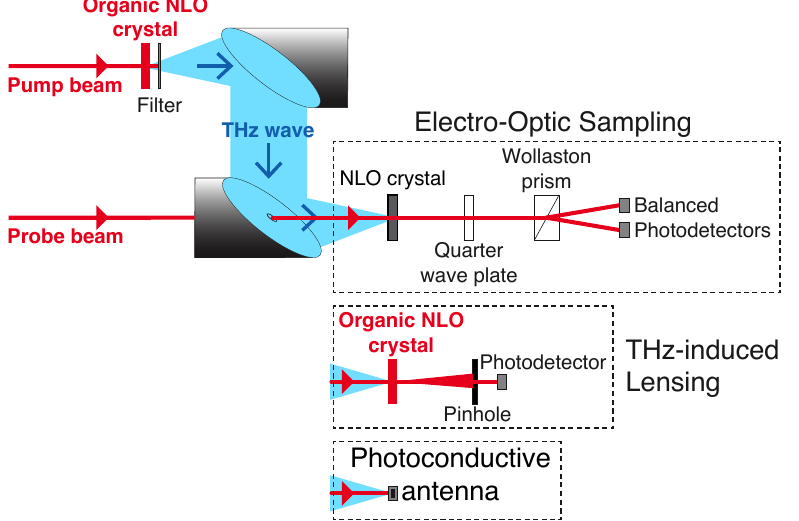
Figure 7. Schematics of a possible experimental geometry for THz-wave generation based on optical rectification with an organic electro-optic crystal as THz generator, indicating some of the possible coherent detection approaches: electro-optic sampling (EOS) with inorganic electro-optic crystals such as ZnTe or GaP, THz-induced lensing with organic electro-optic crystals, or detection with a photoconductive antenna. The pump and the probe fs beams can be of the same or of a different wavelength, but they have to be synchronized. The signal, proportional to the THz electric field E THz ( t ) , is measured as a function of the delay between pump and probe